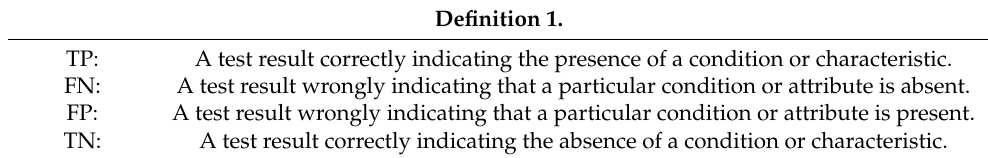
Table 2. Definition of true positive (TP), true negative (TN), false positive (FP) and false negative (FN). Definition